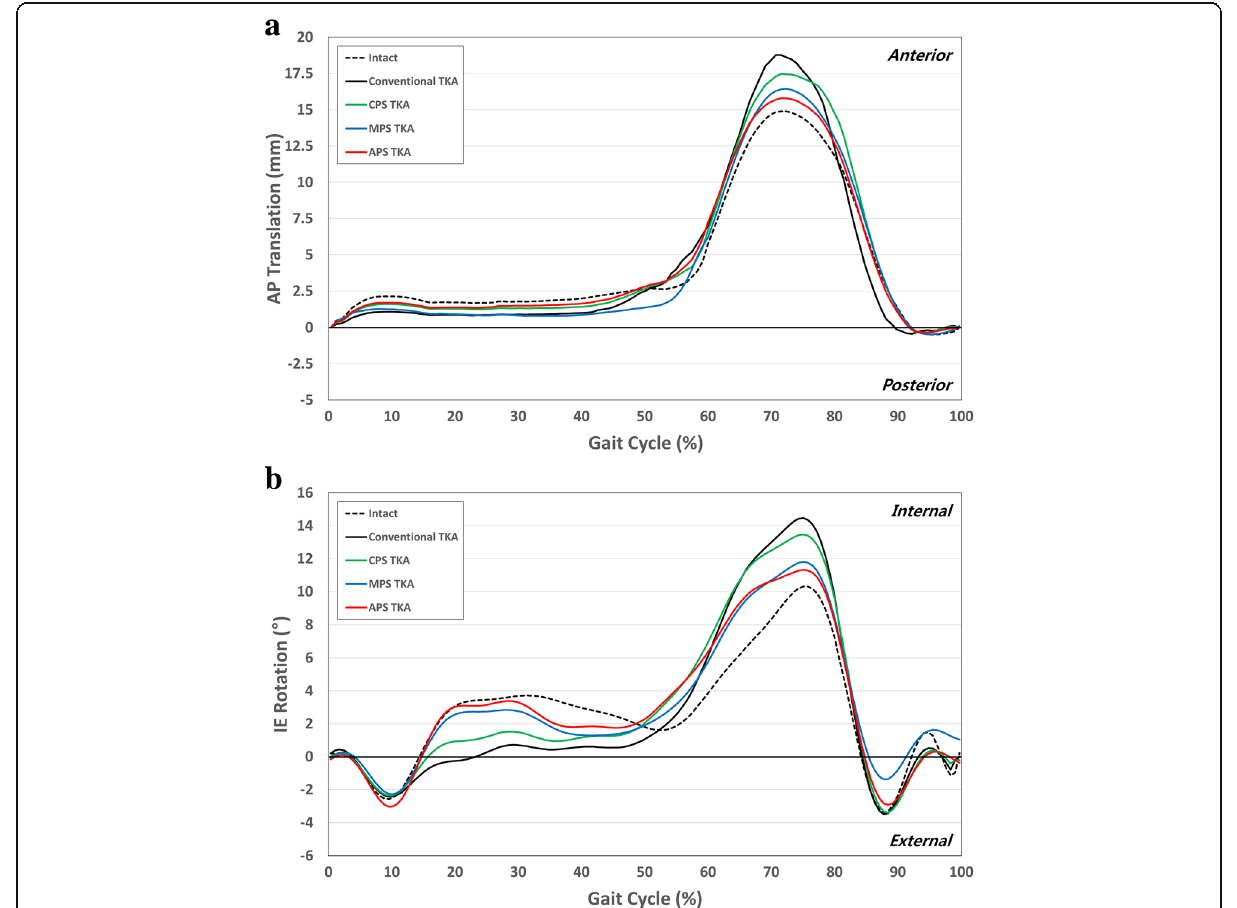
Fig. 4 Comparison of a AP and b IE kinematics between conventional TKA and three different conformity of patient-specific TKA during gait